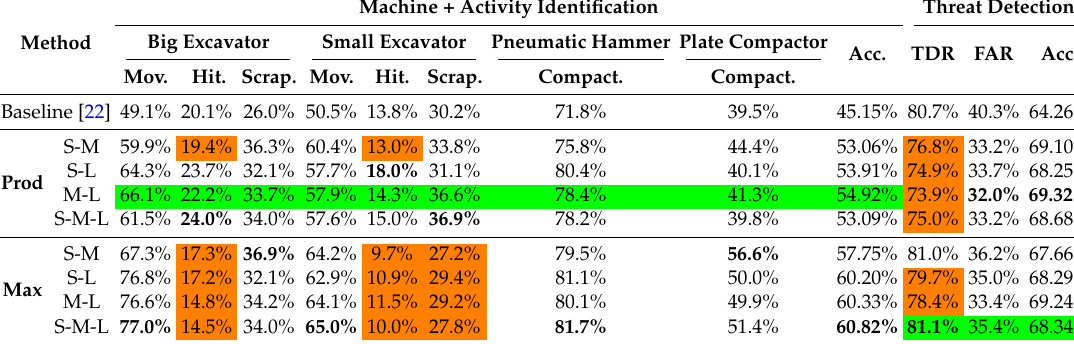
Table 4. Decision combination results. Class classification accuracy and overall classification accuracy for the machine + activity identification mode and the threat detection rate (TDR), false alarm rate (FAR) and overall classification accuracy for the threat detection mode with the best results in bold font. For combination, ”Prod” is the product method, and ”Max” is the maximum method. ”S” denotes short window size; ”M” denotes medium window size; and ”L” denotes long window size. ”Acc.”, ”Mov.”, ”Hit.”, ”Scrap.” and ”Compact.” denote the same as in Table 2. Machine + Activity Identification Big Excavator Small Excavator Pneumatic Hammer Plate Compactor Method Acc. TDR FAR Acc. Mov. Hit. Scrap. Mov. Hit. Scrap.